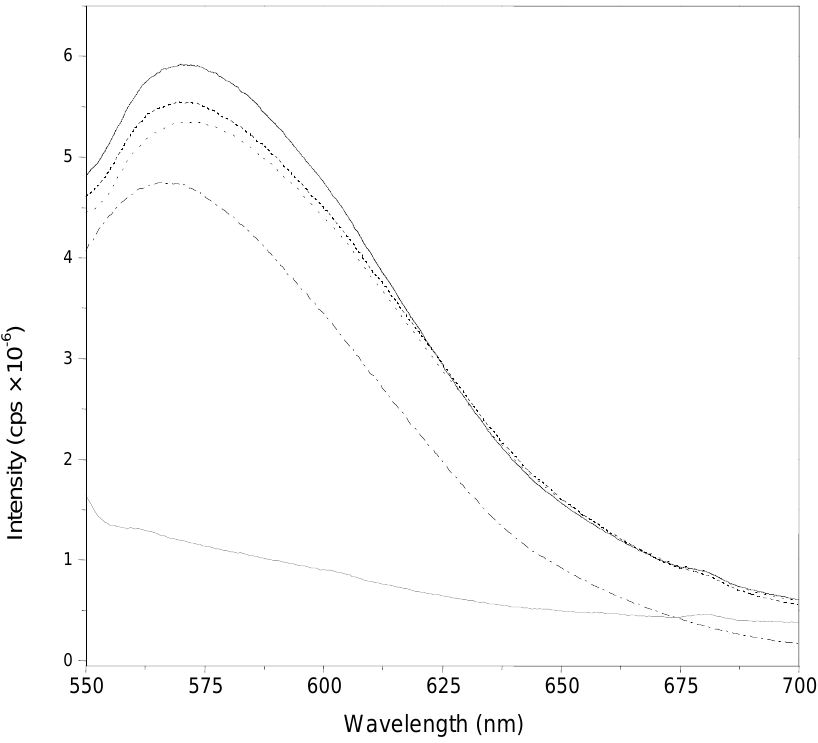
Figure 7. Emission spectrum of Red Nile in olive oil and water, and inside different nanoparticles. (black line) EPI; (dashed line) CS; (dotted line) PhS; (dash-dot line) Olive oil; (gray line)